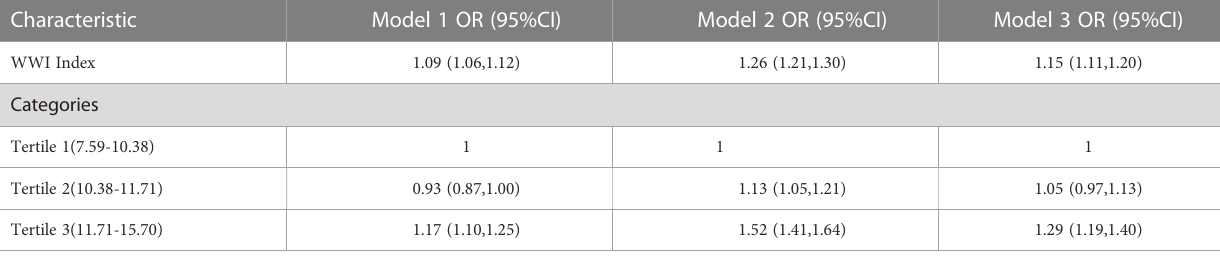
TABLE 2 Logistic regression analysis between WWI index with asthma prevalence. Characteristic Model 1 OR (95%CI)